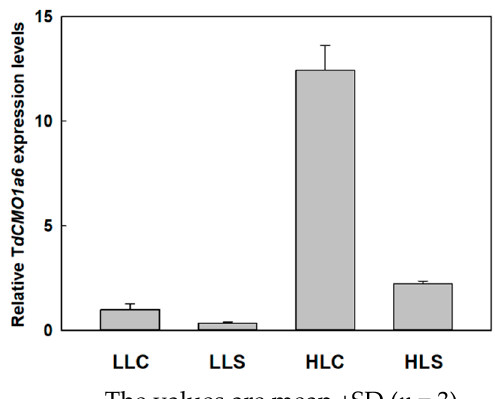
Figure 2. Relative putative TdCMO1a6 gene expression levels. The experiments were performed on three biological replicates. Transcript levels were normalized using the actin gene. The abbreviations indicate: LLC, cDNA from low light control leaves; LLS, cDNA from low light salt-stressed leaves; HLC, cDNA from high light control leaves; HLS, cDNA from high light salt-stressed leaves.